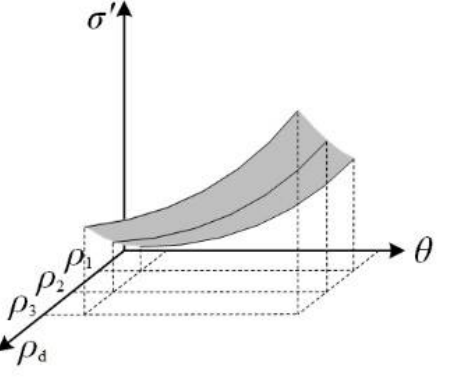
Figure 1. Schematic of an electrical conductivity constitutive surface (ECCS) to characterize in-phase conductivity σ (cid:48) as a function of dry density ρ d and volumetric water content θ . For porous media, such as soils, there exist equivalent circuit models to characterize the frequency dependence of the measured complex resistivity. One common model is shown in Figure 2, where R 1 and Q 1 model the contact resistance and double layer capacitance at the soil–electrode interface; R 2 , Q 2 , and R 4 represent the resistance, the capacitance and the shift resistance at the grain-boundary; and R 3 and Q 3 describe the grain interior conduc- tion [26,39]. The constant phase element (CPE) Q with the impedance ˆ Z ( ω ) = 1/ Q ( i w ) α is applied to represent a non-ideal capacitor, owing to the heterogeneities of the measured materials.